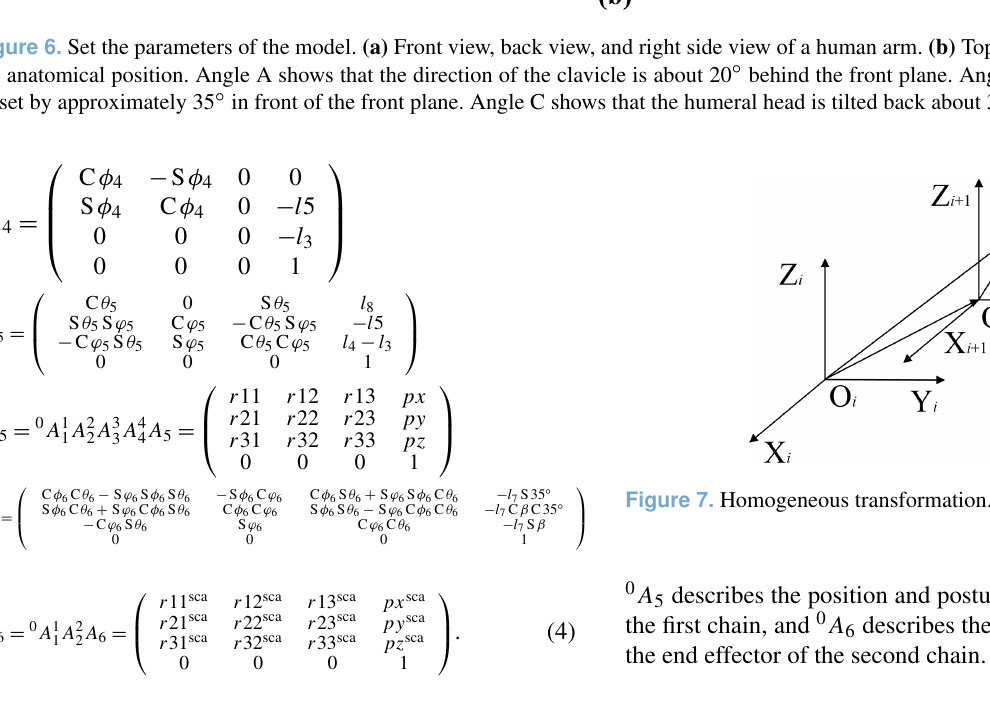
0 A 5 describes the position and posture of the end effector of the first chain, and 0 A 6 describes the position and posture of the end effector of the second